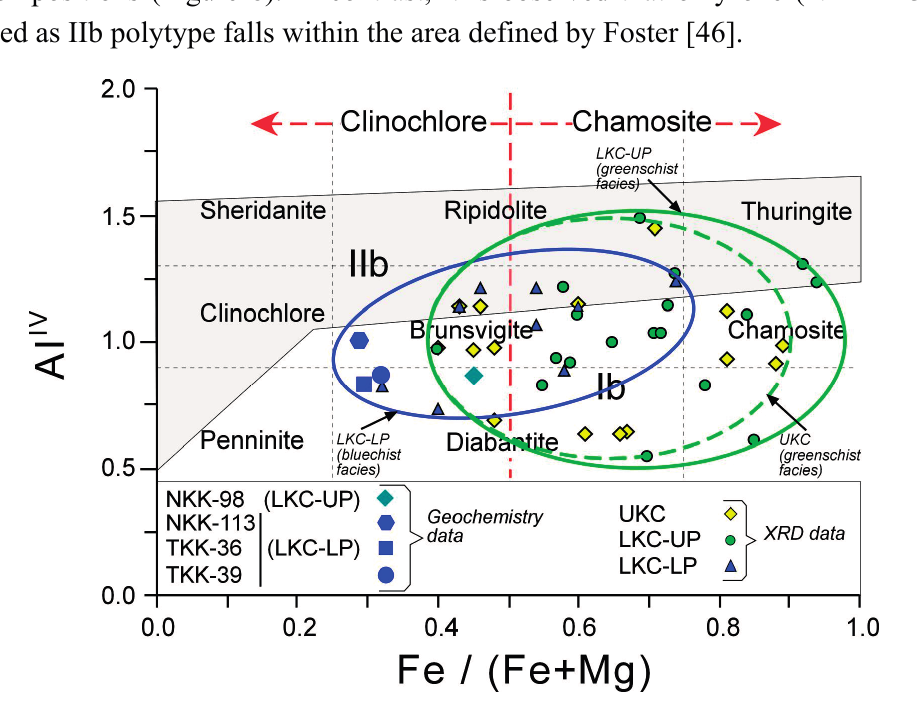
Figure 8. The setting of chlorite minerals in the Karakaya Complex units in tetrahedral Si-octahedral Fe/(Fe + Mg) diagram (Classification and IIb polytype area: Foster [46]; Ib polytype area: Curtis et al. [5]; chamosite-clinochlore boundary: Bailey